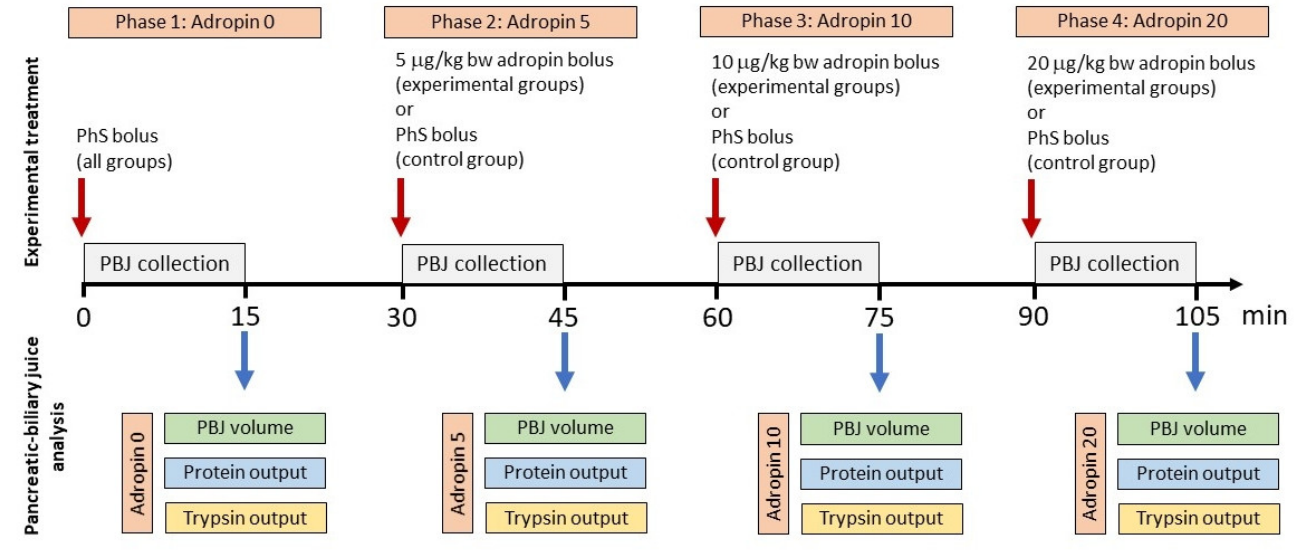
Figure 2. Scheme showing the experimental design.